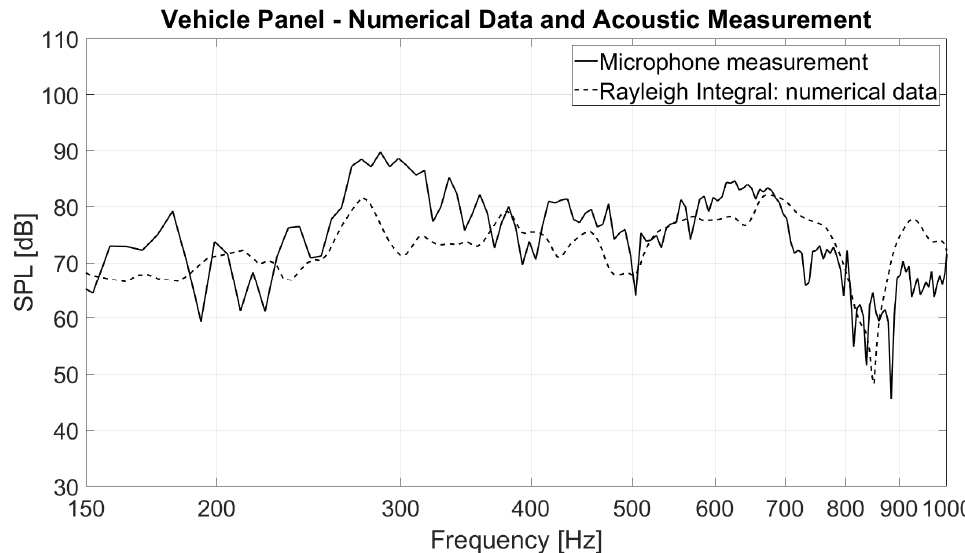
Figure 12. SPL recorded by microphone (solid line) superimposed with SPL calculated by Rayleigh’s integral (dash line) from numerically simulated data.